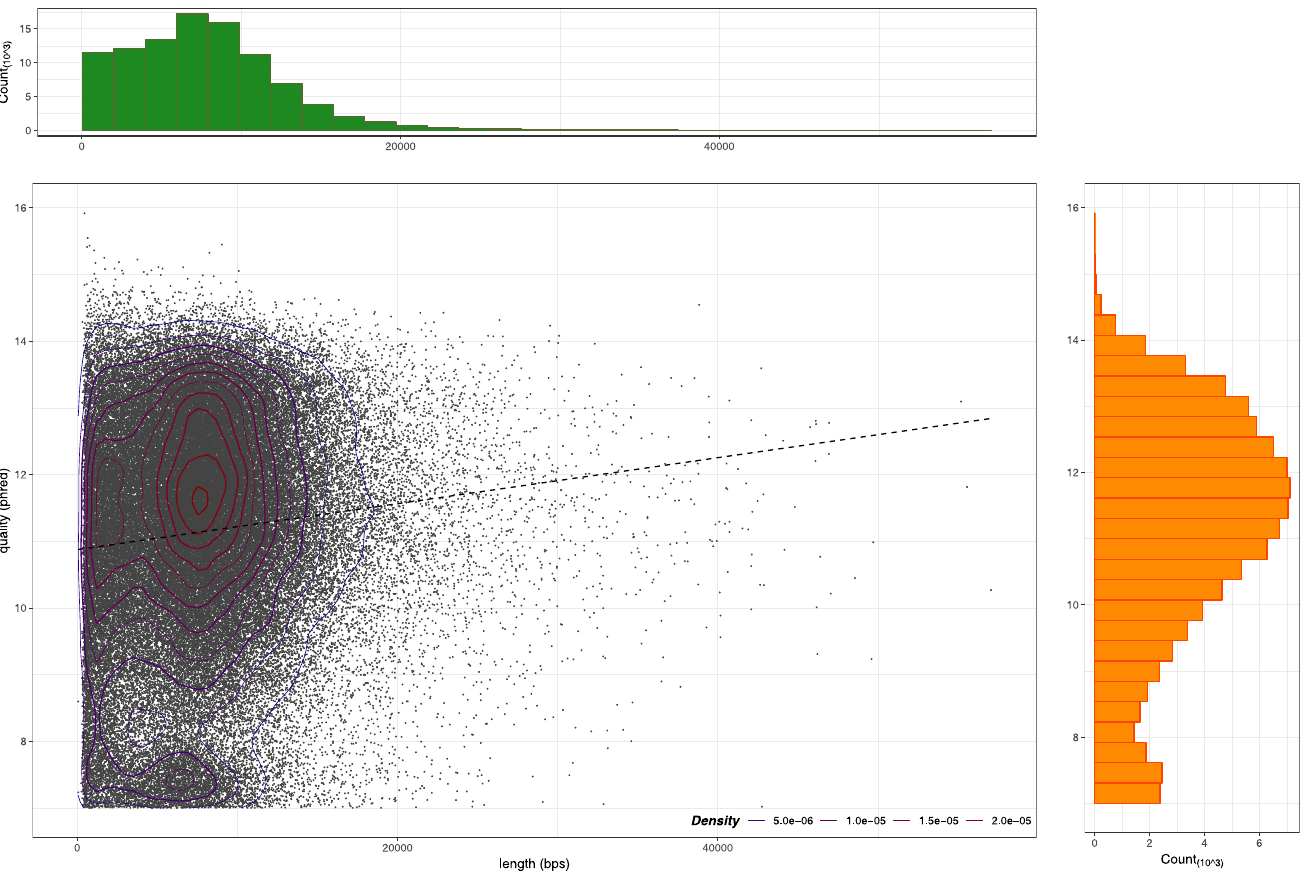
Fig 3. Reads length and reads quality compared jointly. The plot shows the correlation between length (x axis) and quality (y axis) for * 100000 MinION reads. The regression line highlights that longer the reads are, higher their quality score is.